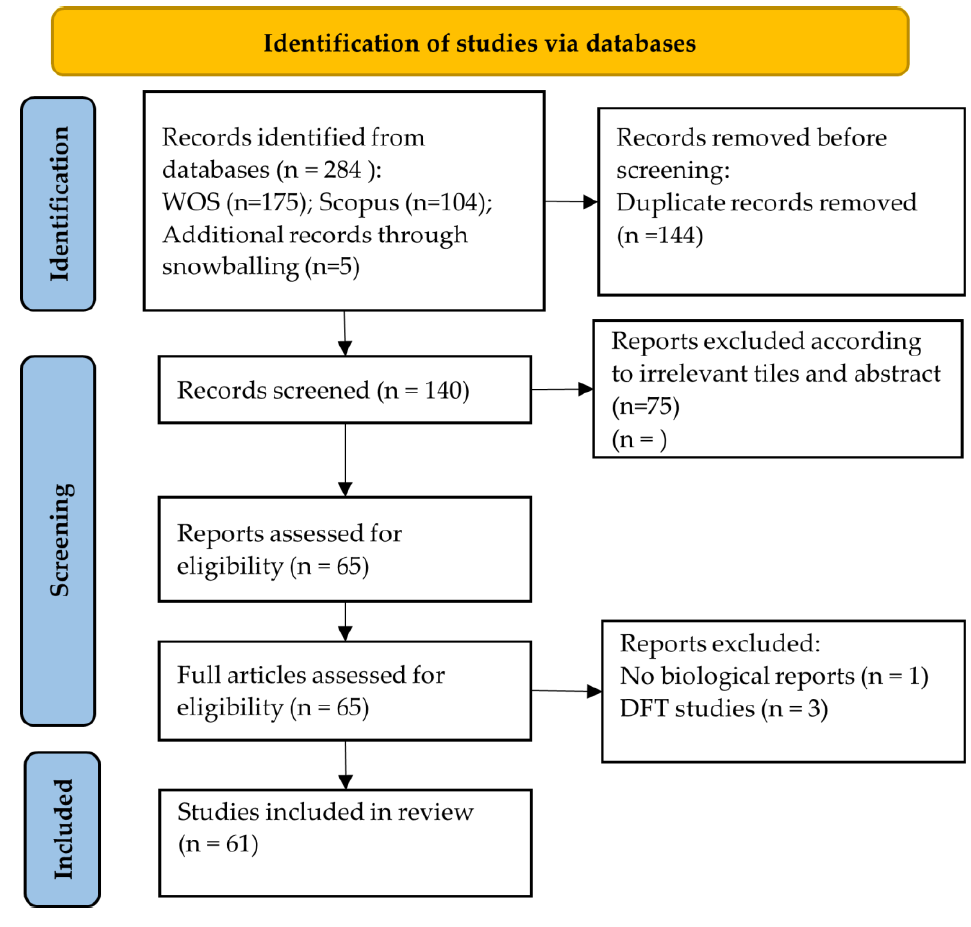
Figure 2. PRISMA search strategy.